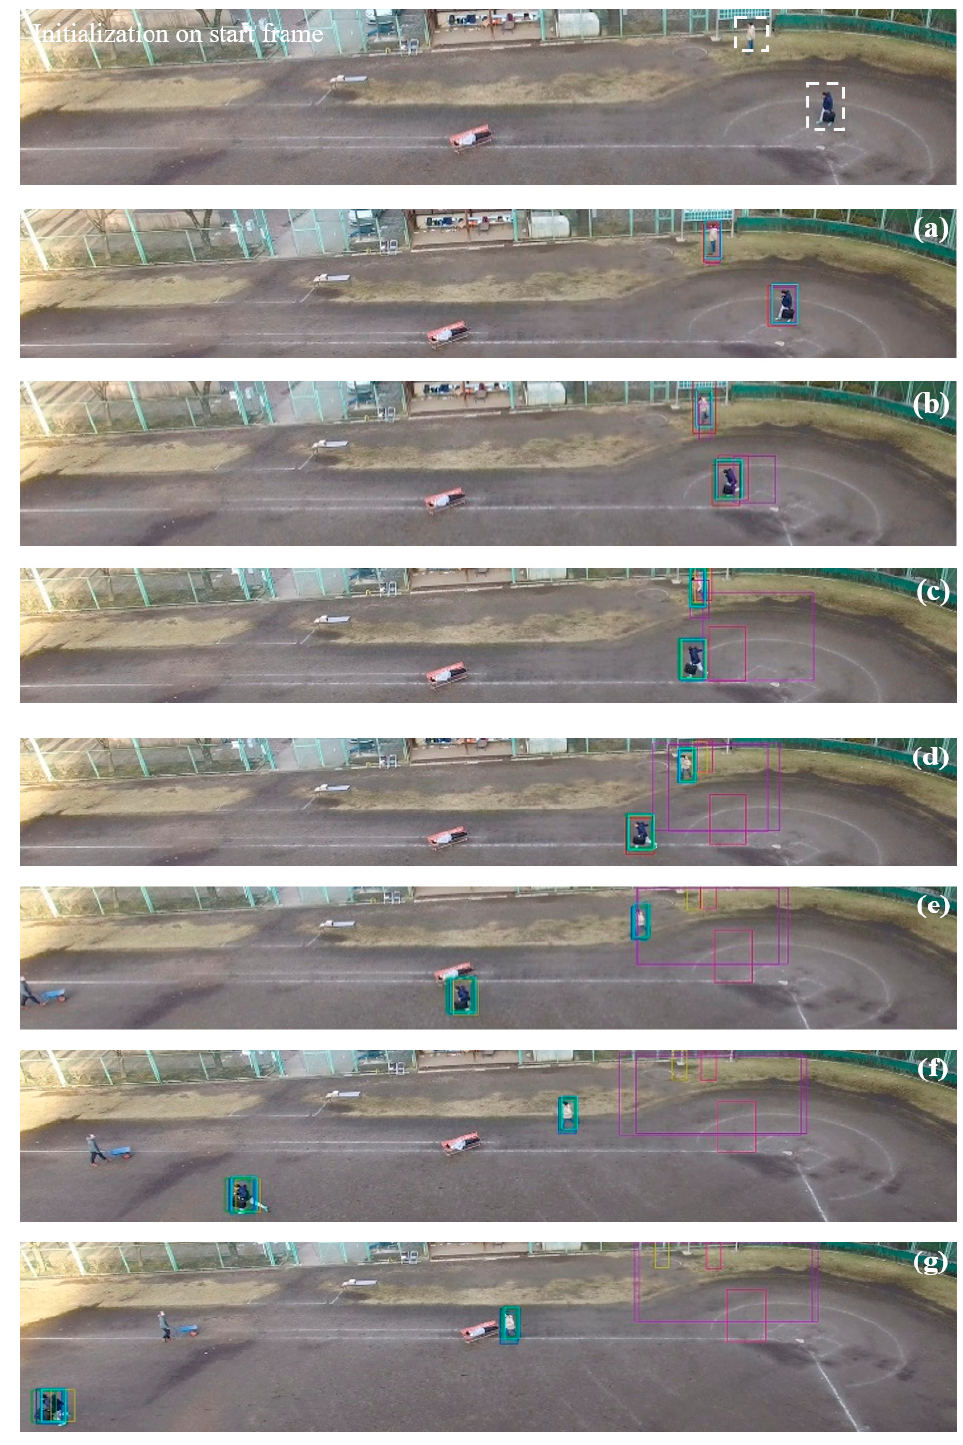
Figure 6. Processed frames as the time progresses (frames ( a – g )) during a multiple person (two objects) tracking process on the OKUTAMA dataset.